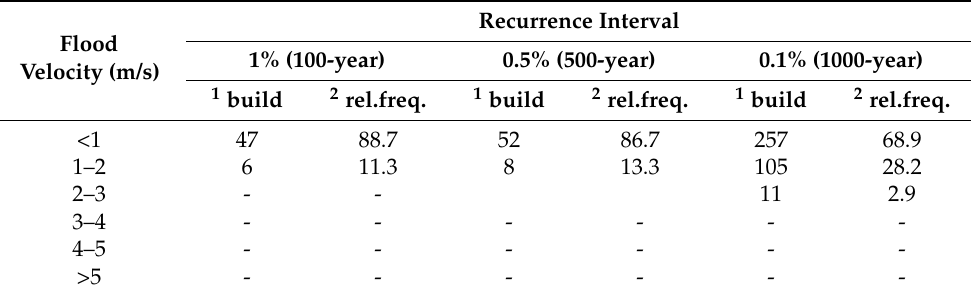
Table 8. Number of buildings with a high potential to be affected and the flood wave velocity computed for each dam break scenario with 1% (100-year), 0.5% (500-year), and 0.1% (1000-year) recurrence